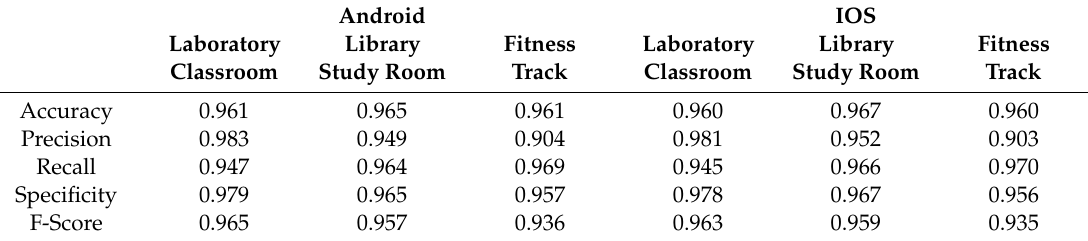
Table 4. Details of results for metrics of the tool